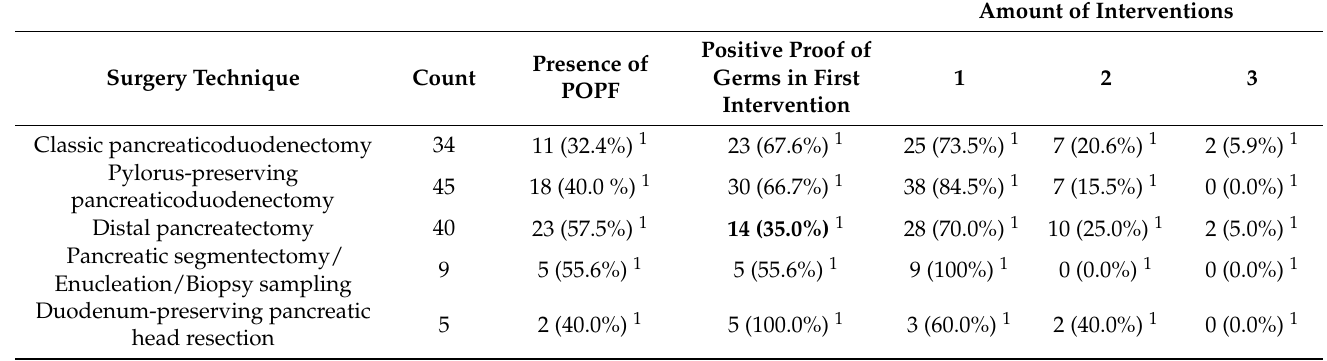
Table 3. Amount of interventions performed for drainage placement in 133 patients, depending on the surgical technique, presence of POPF, and infection status of the fluid collection in the first intervention.